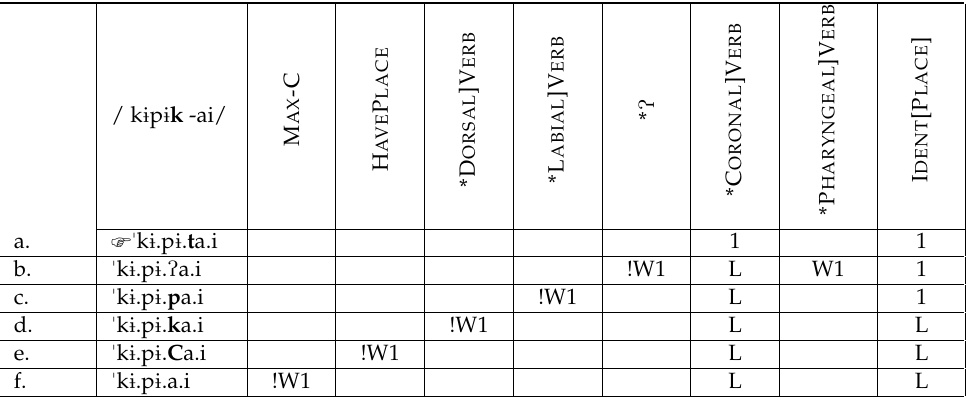
The OT grammar in (68) summarizes how Shipibo-Konibo and Capanahua govern the PoA of their latent segments when they occur as syllable onsets in verb forms. The ranking of *D ORSAL ]V ERB , *L ABIAL ]V ERB , and * P over *C ORONAL ]V ERB and I DENT [P LACE ] turns coronal the default PoA for consonants appearing at the end of a morpheme. The ranking of H AVE P LACE over *C ORONAL ]V ERB and I DENT [P LACE ] ensures that they do not surface as placeless to satisfy the constraints militating against the different places of articulation. The neutralization to coronal occurs regardless of whether the morpheme-final consonant is underlyingly specified for place or not. (68) Constraint ranking to account for PoA of latent segments in verb forms